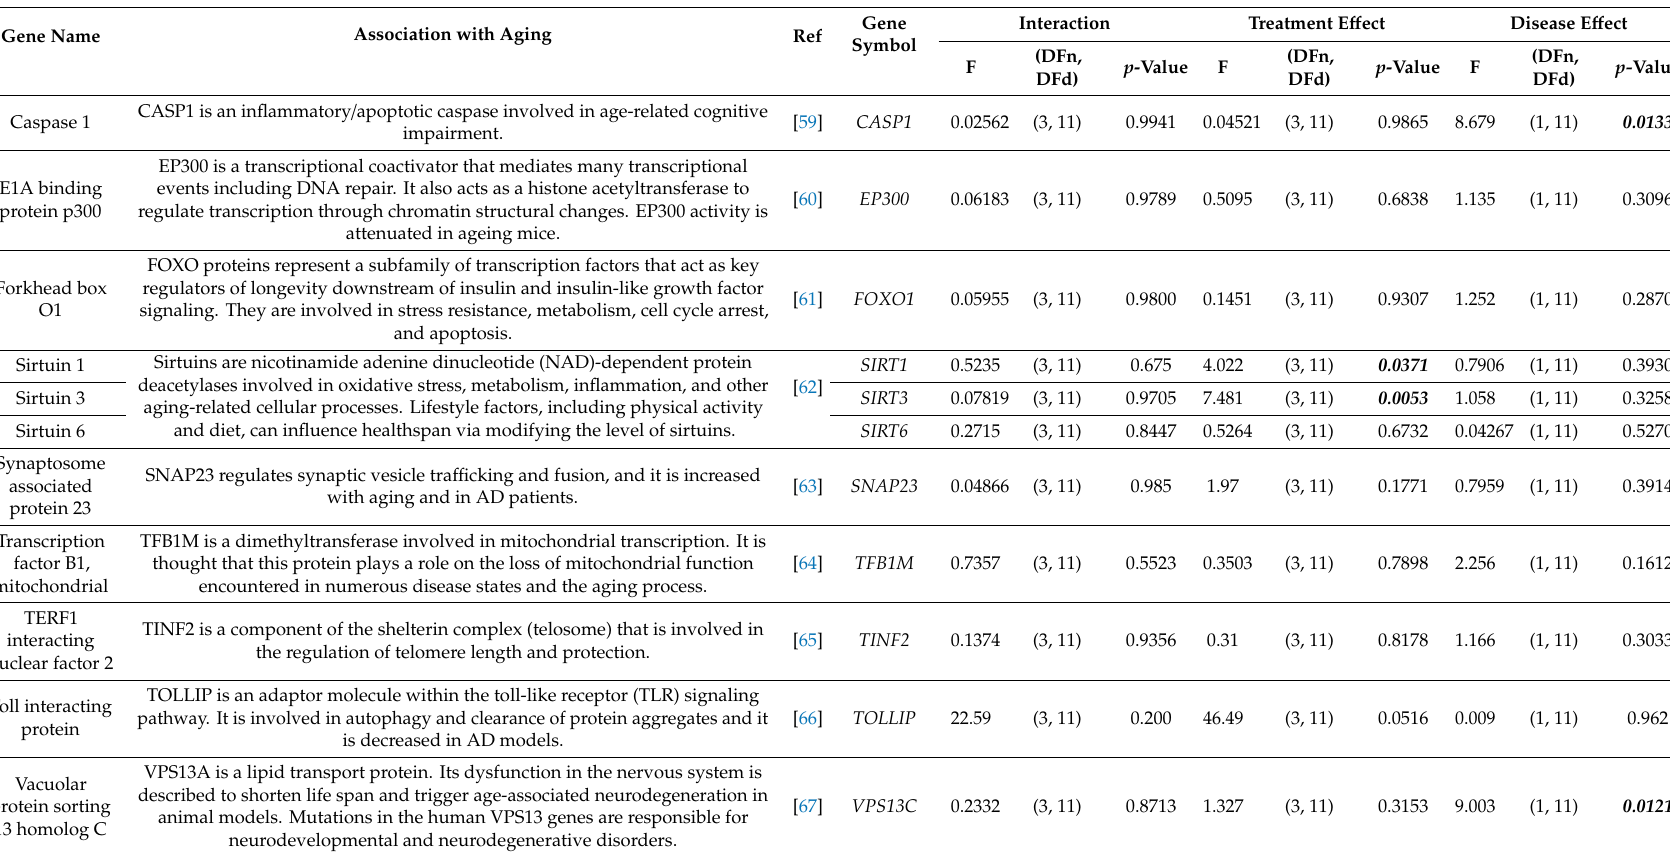
Table 2. Two-way ANOVA analysis of relative expression of age-related genes in AD and HC lymphoblasts treated with selenite (Se (IV)), selenate (Se (VI)), and resveratrol